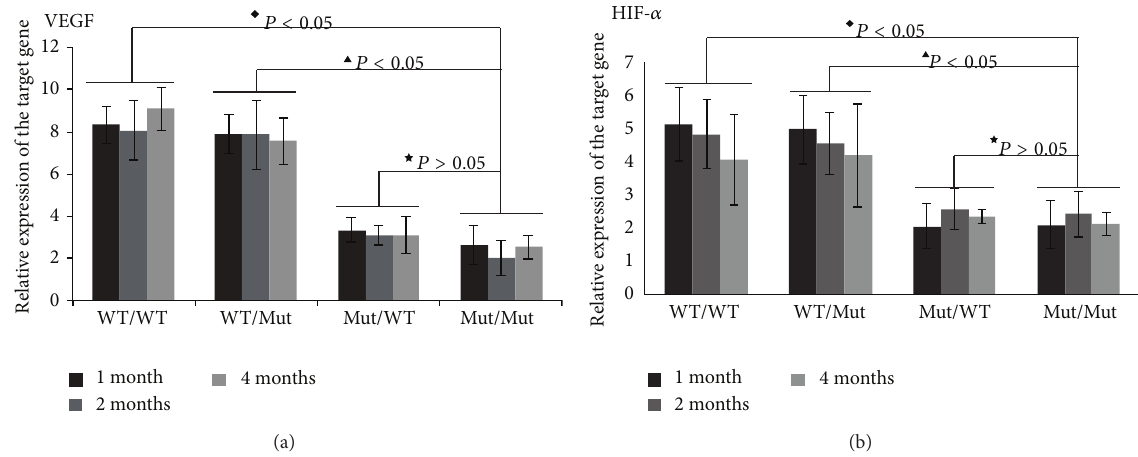
Figure 4: VEGF and HIF-1 𝛼 mRNA expression in whole retinal tissue as detected by qt-PCR. The data are represented as the means ± SD (4–6 mice in each group), X 𝑃 < 0.05 , compared between WT/WT and Mut/Mut groups; 󳵳 𝑃 < 0.05 , compared between WT/Mut and Mut/Mut groups; 󳀅 𝑃 > 0.05 , compared between Mut/WT and Mut/Mut groups in the same time